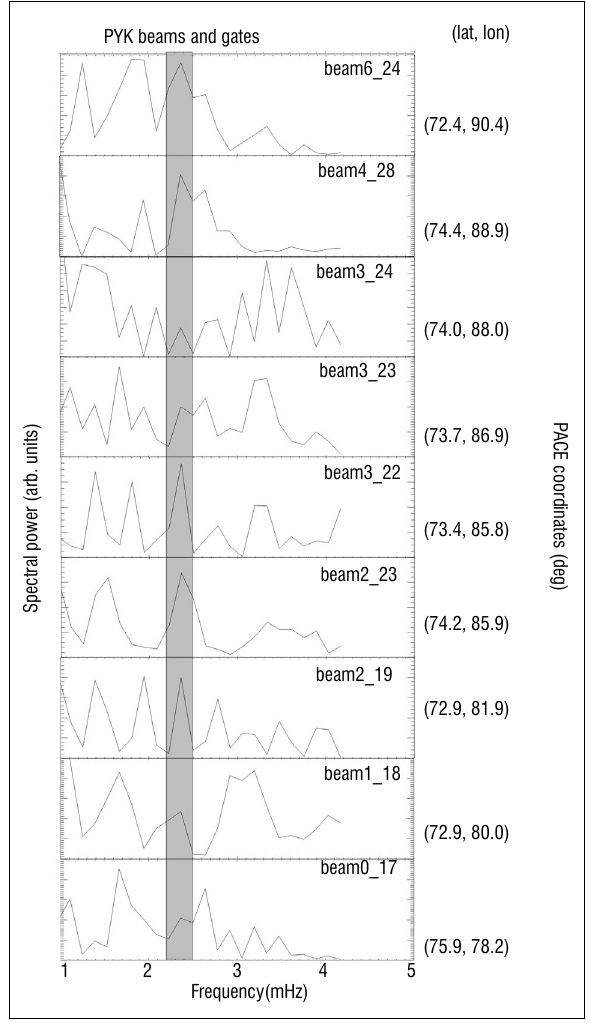
Figure 7: Fourier power spectra of the Þykkvibaer radar for the given beams and